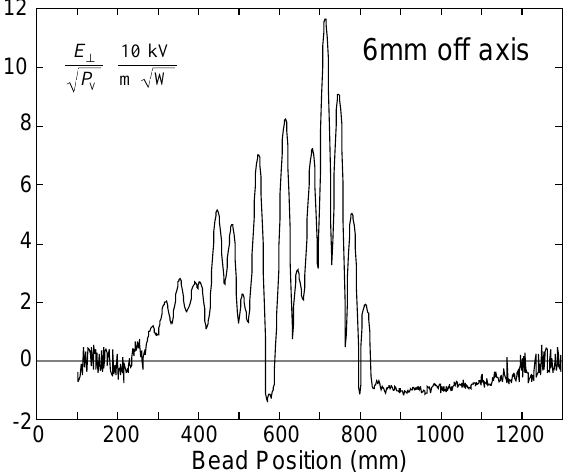
FIG. 6. Measurement: longitudinal (cid:69) field of mode